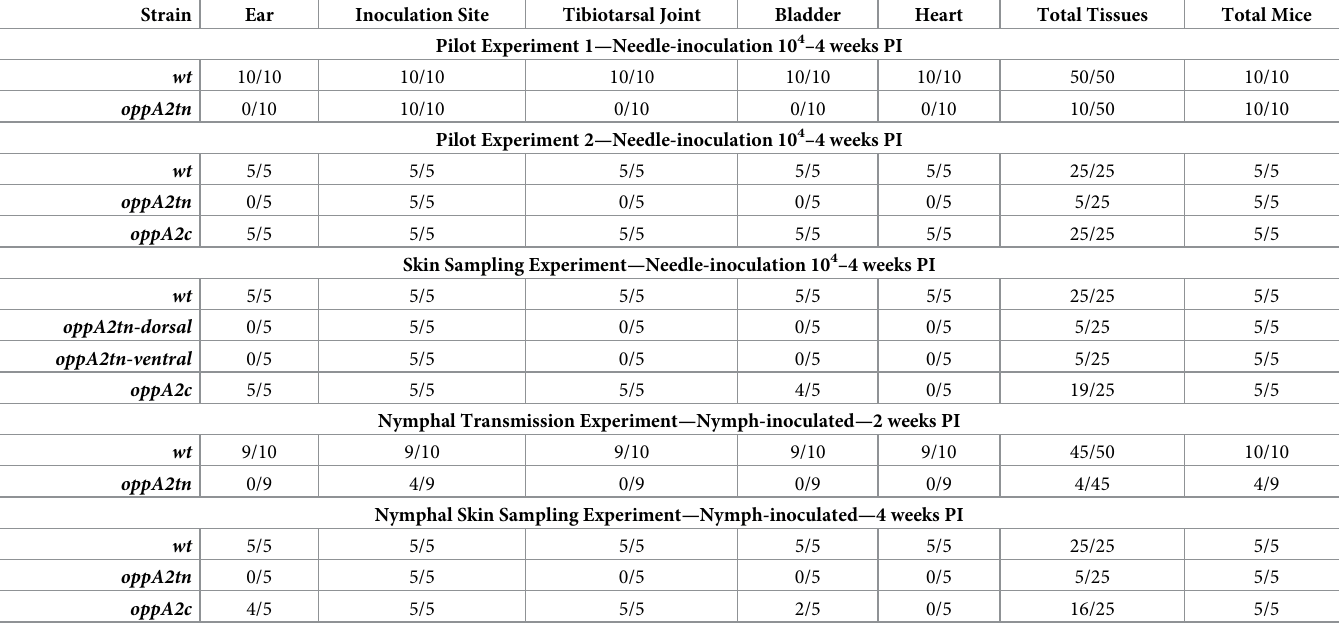
Table 2. oppA2 positive tissue culture data. Strain